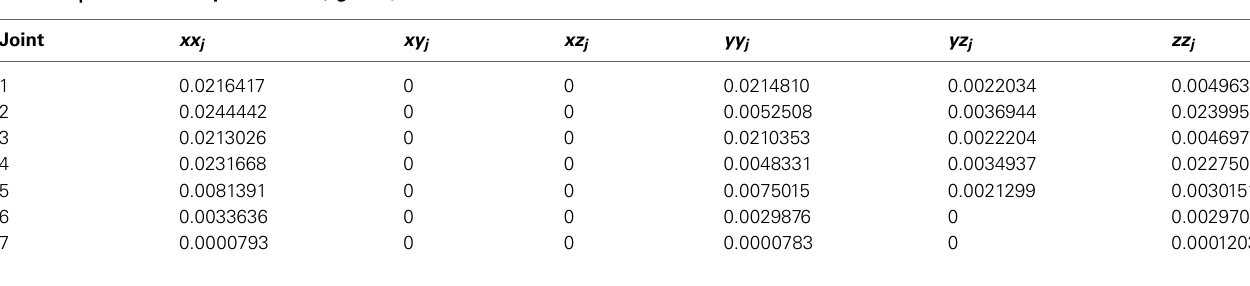
Table B2 | Centers of masses ( m ) , masses ( kg ) and motor inertias ( kg · m 2 ) . Joint